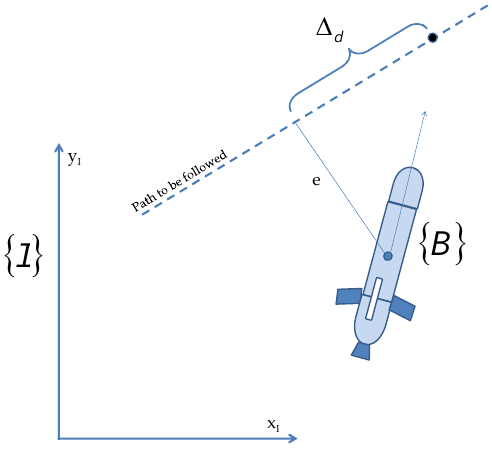
Figure 10. Line-of-sight guidance using look-ahead distance